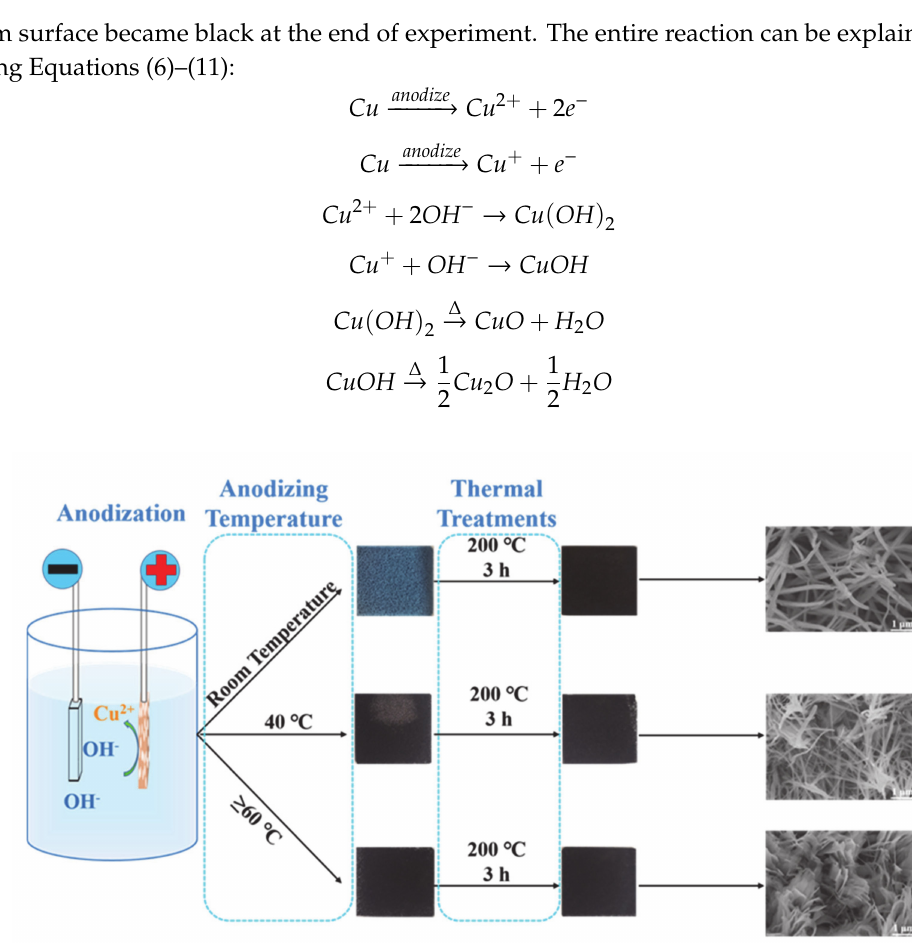
Figure 8. The synthesis process of CuO / Cu foam